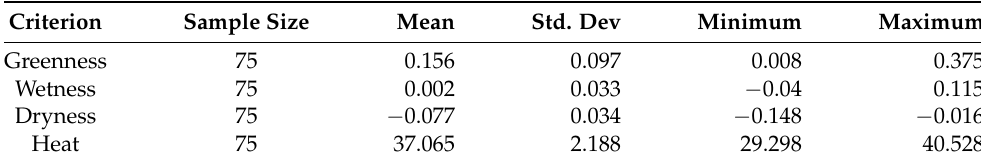
Table 4. Descriptive statistics for ecological criteria.